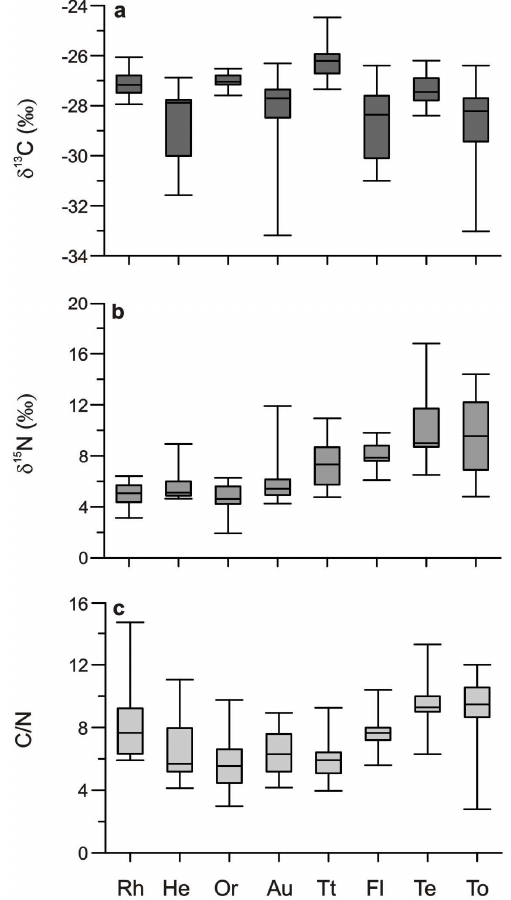
Fig. 8. Spatial variations of the stable isotopes δ 13 C (a) and δ 15 N Figure 8. Spatial variations of the stable isotopes d 13 C (a) and d 15 N (b) and C/N ratio (c) from 864 (b) and C/N ratio (c) from November 2008 to December 2009. The box plot shows the extreme values, the quartiles and the mean value November 2008 to December 2009. The boxplot shows the extreme values, the quartiles and 865 of each the mean value of each river. 866